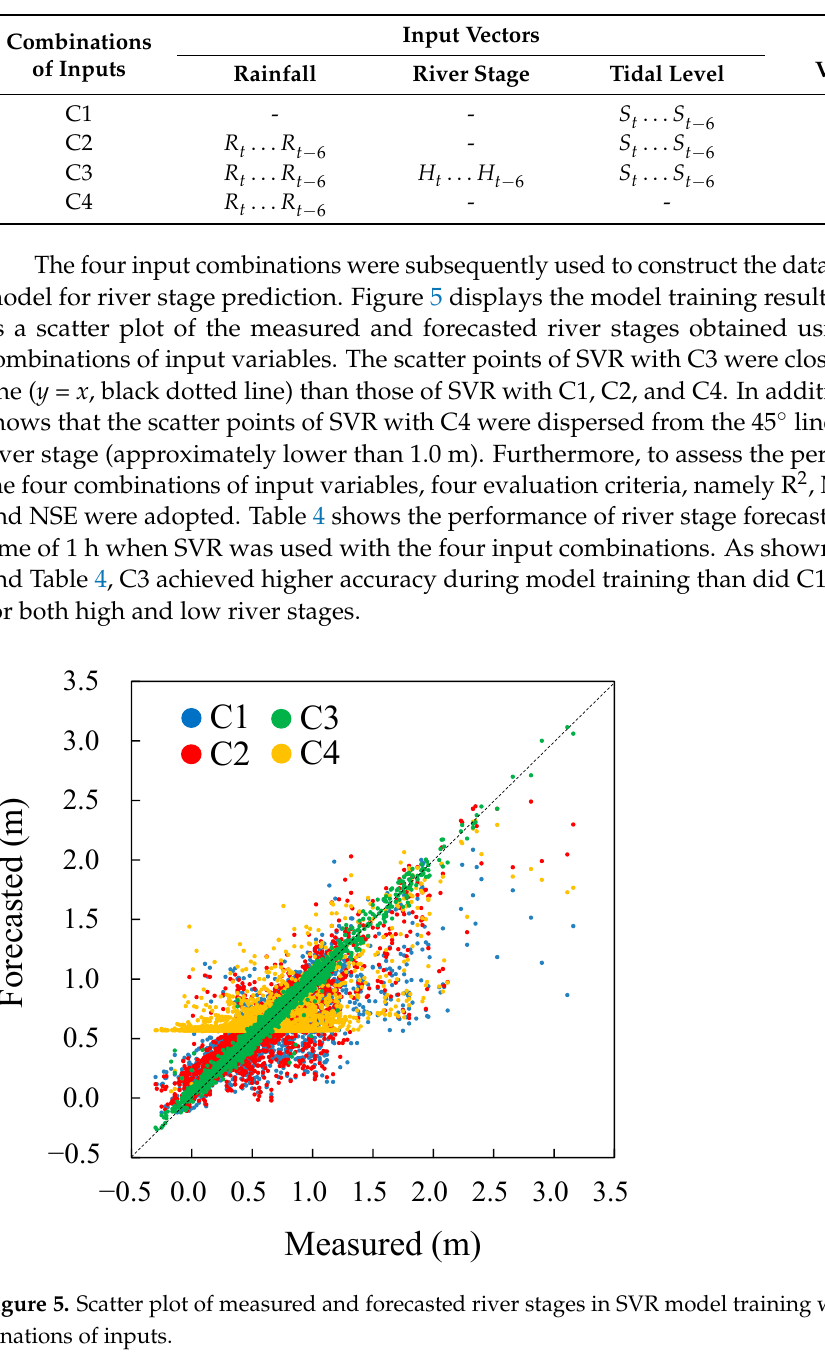
Table 3. Four combination scenarios for conducting optimal inputs.